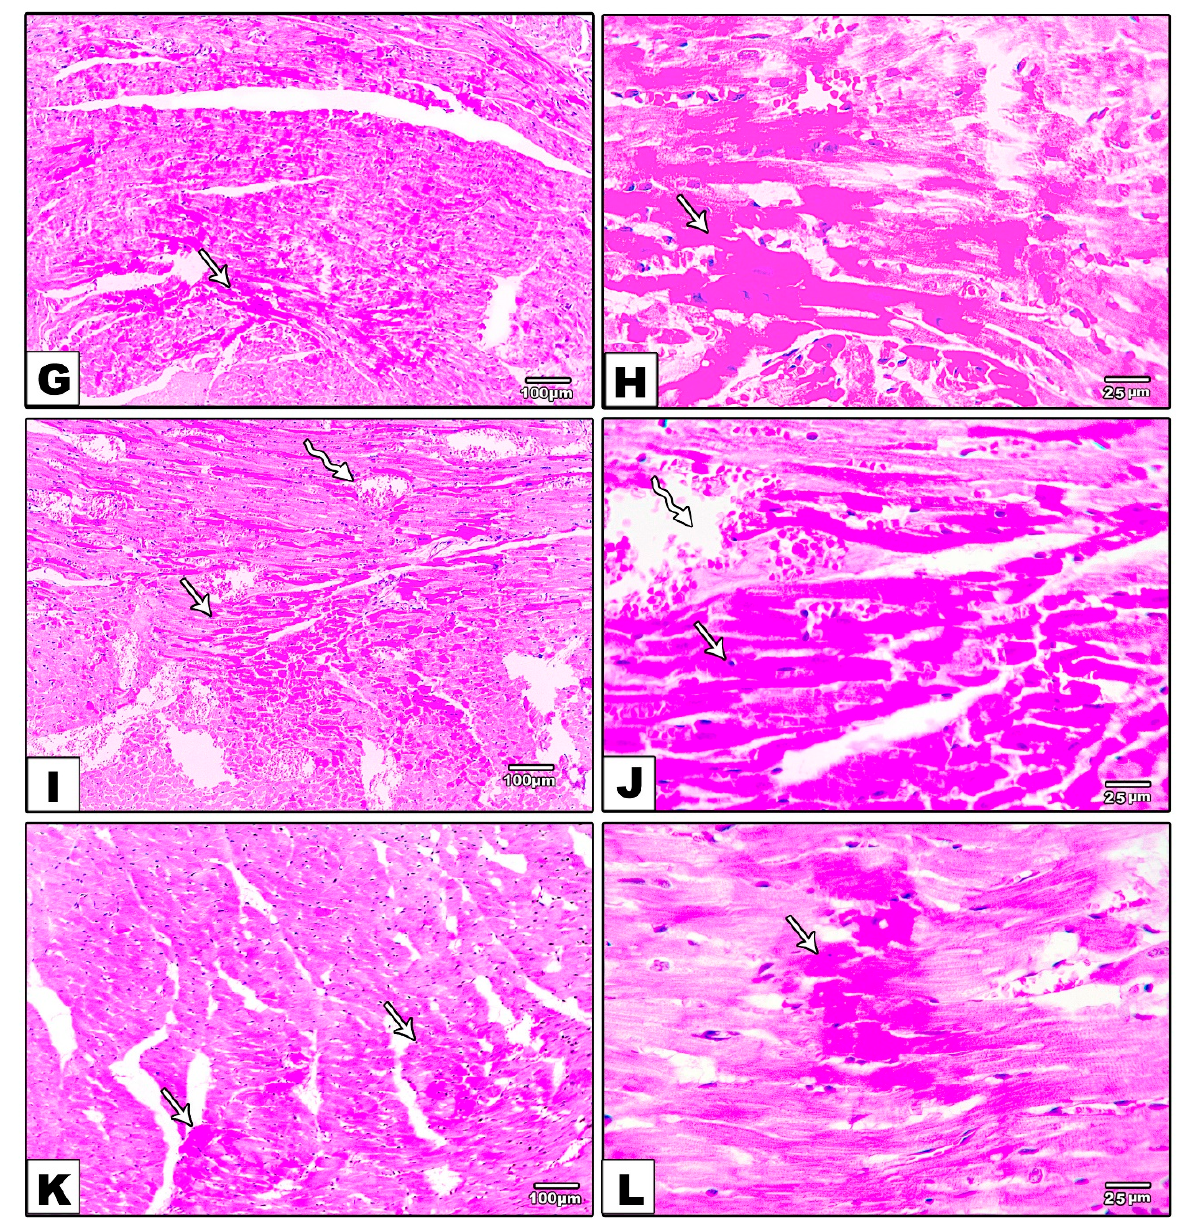
Figure 3. H & E-stained sections, ( A , B ) from the control group showing regularly arranged cardiomyocytes and their nuclei (white arrows), ( C – F ) from the DM group show multifocal hyalinization areas with pyknotic nuclei (arrowhead), edema (crossed arrow), fibrosis (thick arrow), and vacuolization (curved arrow). ( G , H ) from the DM-S group showing a small area of hyalinization with pyknotic nuclei and congestion (white arrow and zigzag arrow), ( I , J ) from the DM-F group show a small area of hyalinization with pyknotic nuclei (white arrow) and ( K , L ) from DM-SF group showing a regular arrangement of cardiomyocytes and a very minimal small area of hyalinization with pyknotic nuclei (white arrow).